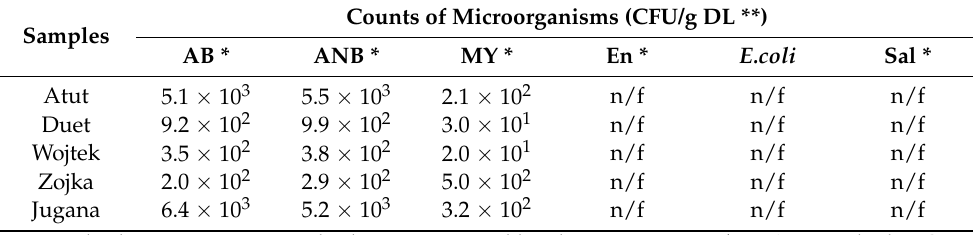
Table 1. Microbiological purity of haskap berry leaves.